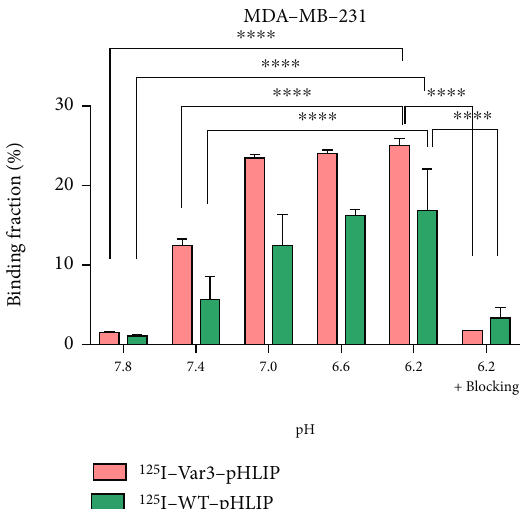
Figure 3: Binding fractions of 125 I-labeled pHLIPs to MDA-MB-231 cells at di ff erent pH values. The binding fractions to MDA-MB-231 cells from pH 7.8 to 6.2 were 0 : 83 ± 0 : 21 , 5 : 53 ± 2 : 88 , 12 : 33 ± 3 : 97 , 16 : 07 ± 0 : 81 , and 16 : 70 ± 5 : 28 for 125 I-WT-pHLIP and 1 : 30 ± 0 : 10 , 12 : 3 ± 0 : 80 , 23 : 40 ± 0 : 44 , 23 : 88 ± 0 : 55 , and 24 : 90 ± 0 : 96 for 125 I-Var3-pHLIP, respectively. The cell binding fraction at pH 6.2 was signi fi cantly higher than those at pH 7.4 ( p < 0 : 0001 ) and 7.8 ( p < 0 : 0001 ). With an excess of unlabeled peptide, the binding fractions of 125 I-WT-pHLIP or 125 I-Var3-pHLIP to cells at pH 6.2, respectively, decrease to 3 : 11 ± 1 : 35 % and 1 : 50 ± 0 : 11 % . ∗∗∗∗ p < 0 : 0001